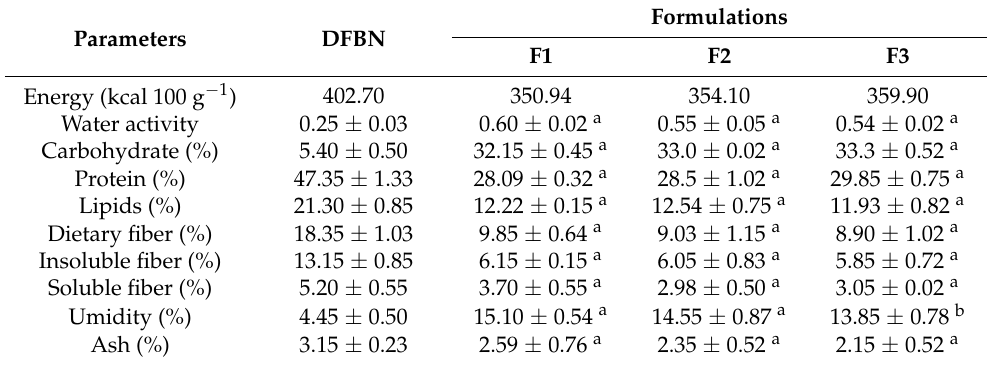
Table 2. Physical and physical-chemical composition of Defatted Flour of Brazil Nuts and